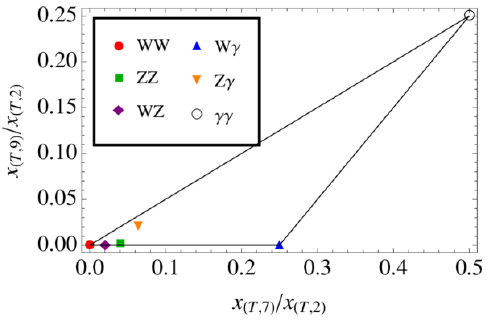
Figure 11 . The 6 rows in M T with a T ? polarisation only involve F T; 2 , F T; 7 and F T; 9 . The corresponding ~x i vectors have 3 components. The plot shows the intersection points P i =